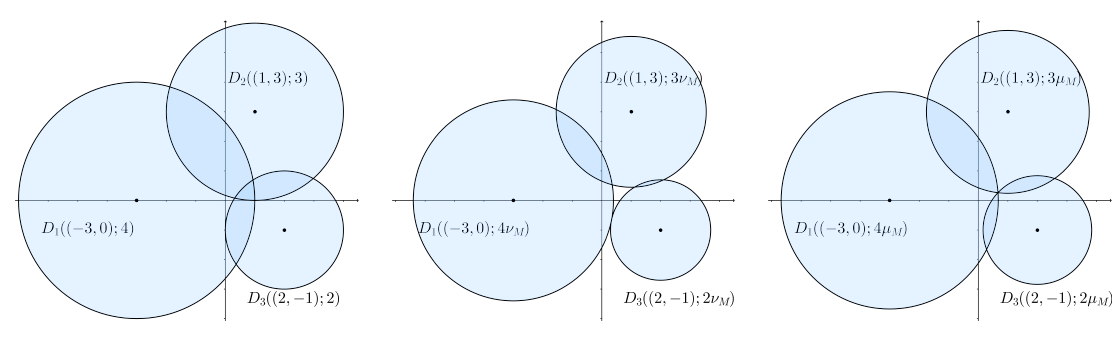
Figure 1. Vietoris–Rips and ˇCech systems in the